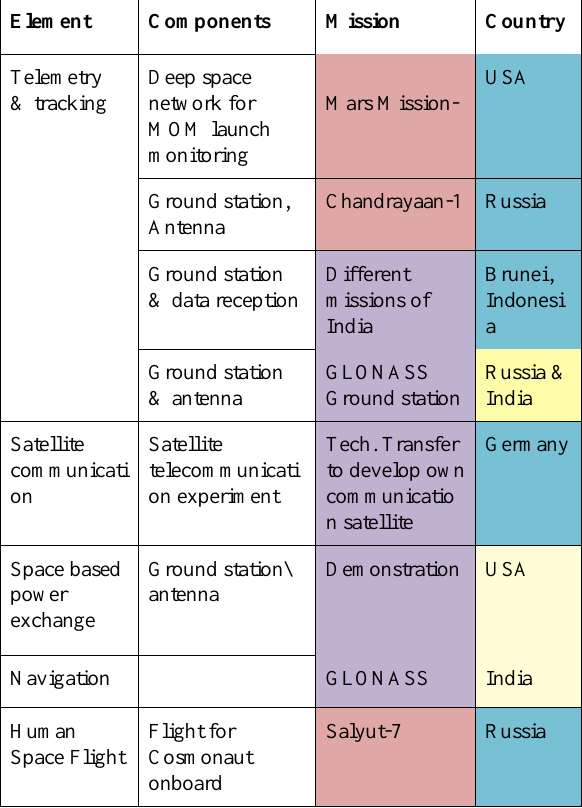
Table-3 Cooperation in ground segment and other